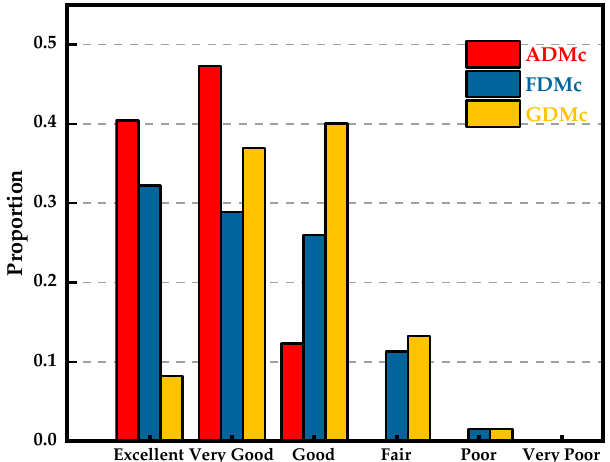
Figure 19. Confidence histograms of the ADM, FDM and GDM obtained from the FSV analysis of the data of Figure 17.